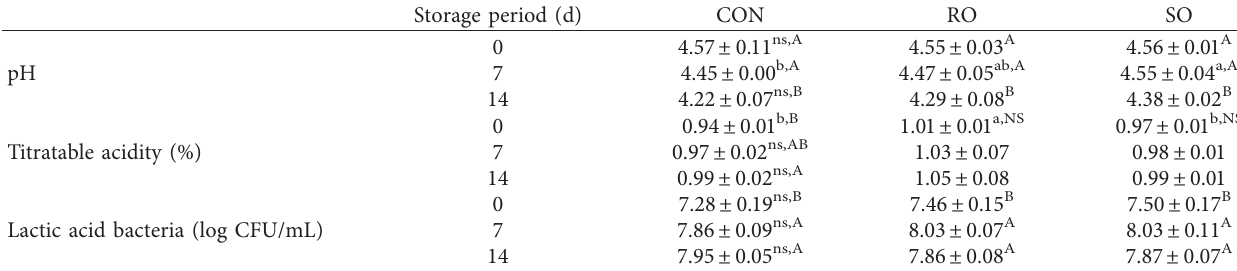
Table 1: pH, titratable acidity, and lactic acid bacteria during the storage of